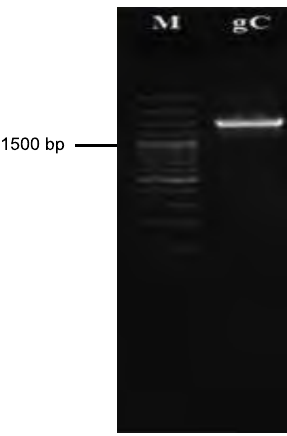
Figure-1. Result of colony PCR for confirmation of presence of amplified glycoprotein C gene insert using universal